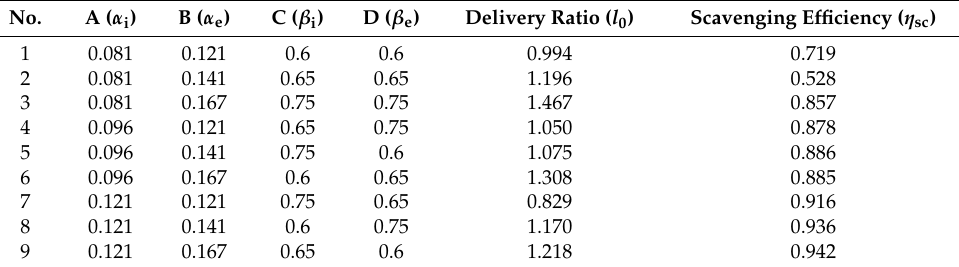
Table 3. Calculation Case and